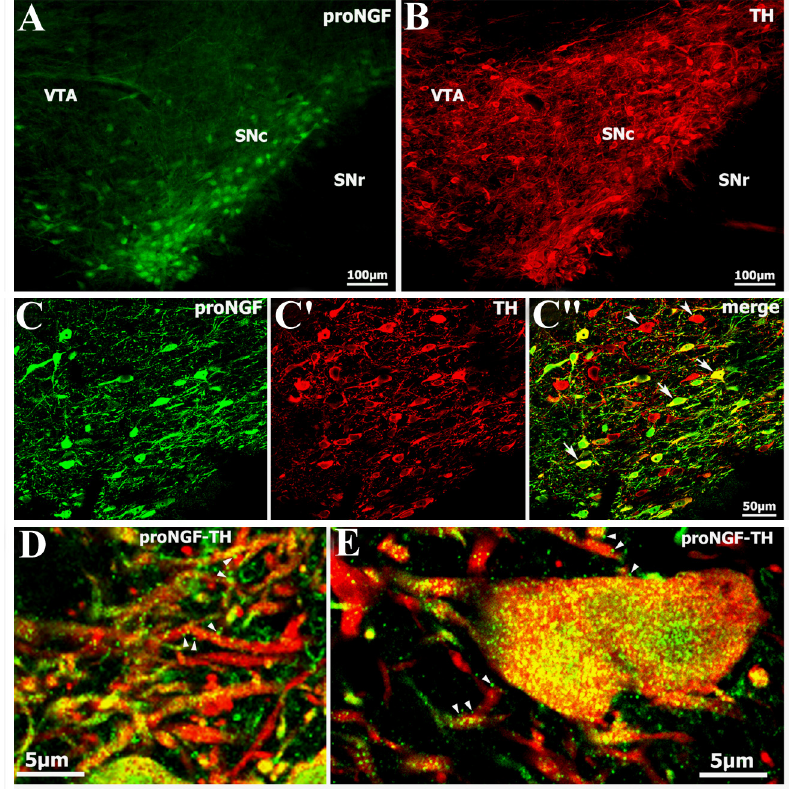
Figure 1. Laser scanning confocal microscopy showing localization of proNGF in dopamine neurons of the substantia nigra of adult rats. The proNGF/TH double-labeled cells are densely distributed in the A9 ventral tier of the substantia nigra pars compacta ( A – C ); The proNGF-positive punctuates or granules (green or yellow color) are localized in neuronal cytoplasm, membrane and extracellular matrix ( D , E ). Arrows indicate proNGF/TH double-labeled neurons ( C ꞌꞌ ), while arrowheads indicate TH single-labeled neurons ( C ꞌꞌ ) or show proNGF-positive punctuates ( D , E ). Abbreviations: SNc, substantia nigra